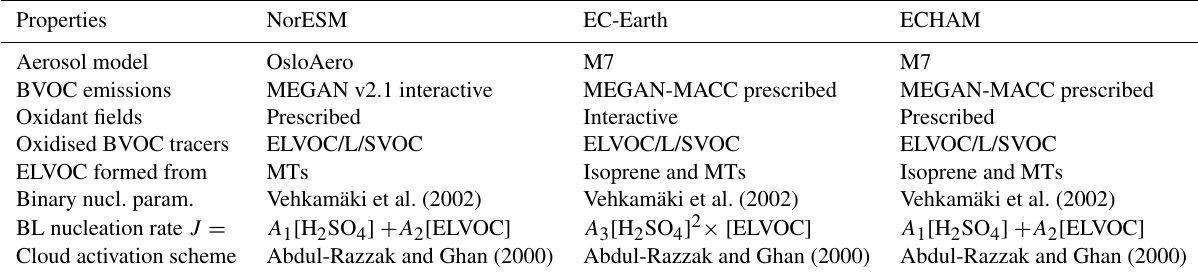
Table 1. This table lists similarities and dissimilarities between the three ESMs of particular relevance for this study. Properties NorESM EC-Earth Aerosol model Oxidant fields Prescribed Interactive Prescribed Oxidised BVOC tracers ELVOC/L/SVOC ELVOC formed from MTs Isoprene and MTs Isoprene and MTs Binary nucl.